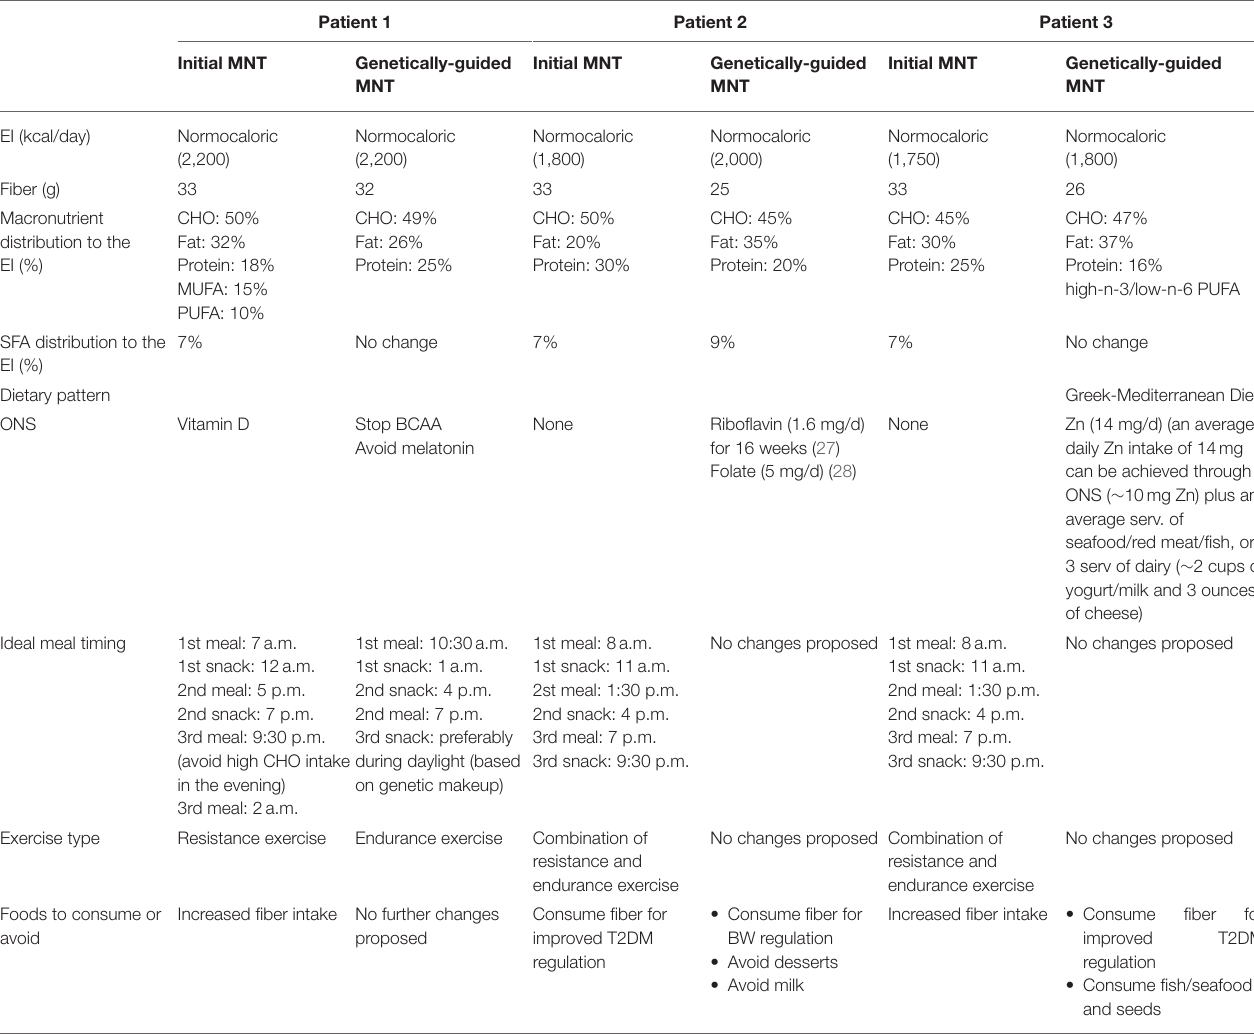
TABLE 2 | Initial MNT prescribed to each case, and genetically-guided MNT prescribed post-nutrigenetic testing. Patient 1 Patient 2 Patient 3 Genetically-guided